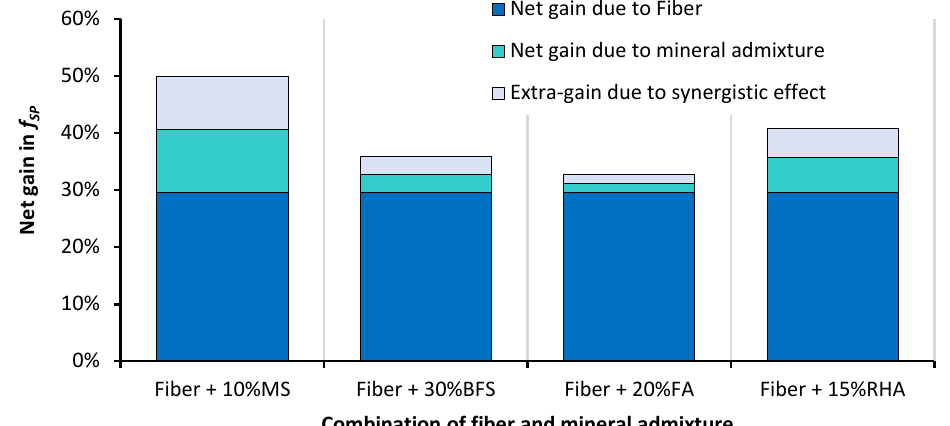
Figure 13. The effect of the combined incorporation of mineral admixtures and glass fibers on the net change in f SP of RAC.